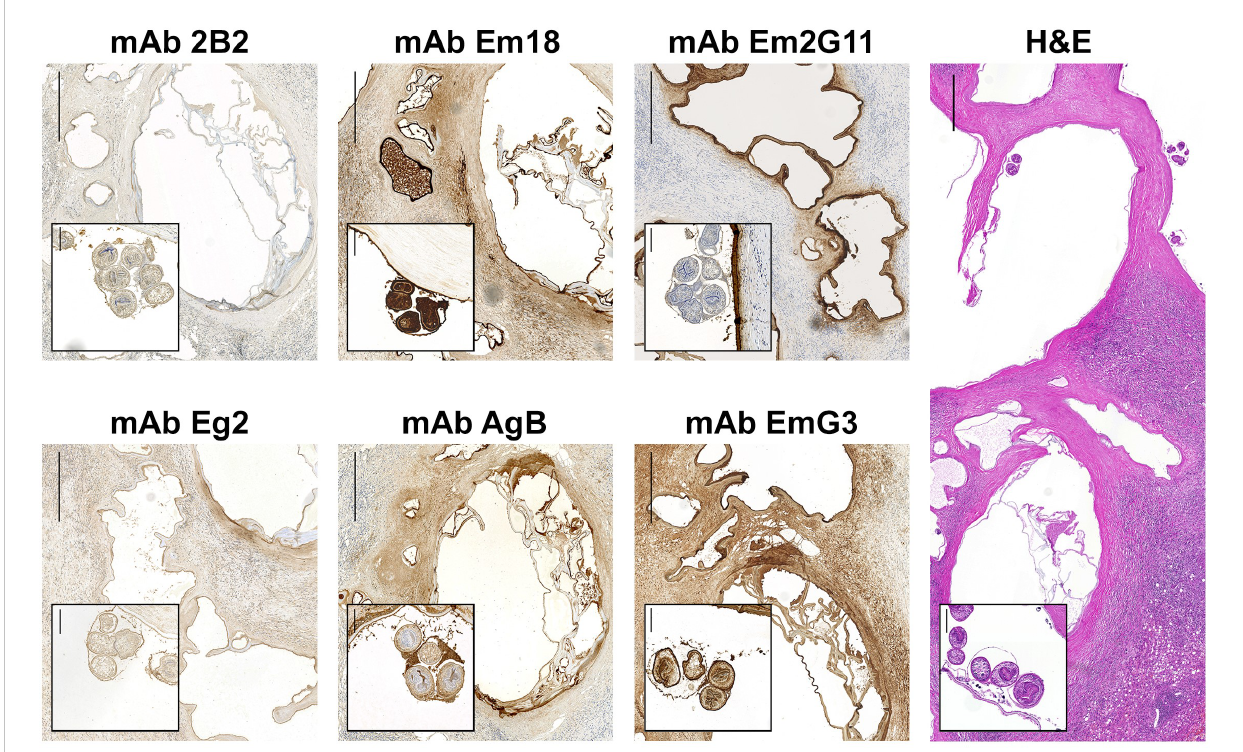
FIGURE 1 Immunohistochemical stainings (IHC-S) with mAbs on liver sections of a patient with alveolar echinococcosis. H&E, Hematoxylin and eosin staining. Scale bars: 1 mm; insets: 100 m m. The enlarged sections are brood capsules of E. multilocularis , surrounded by a germinal layer. A positive staining is connected to a strong brownish